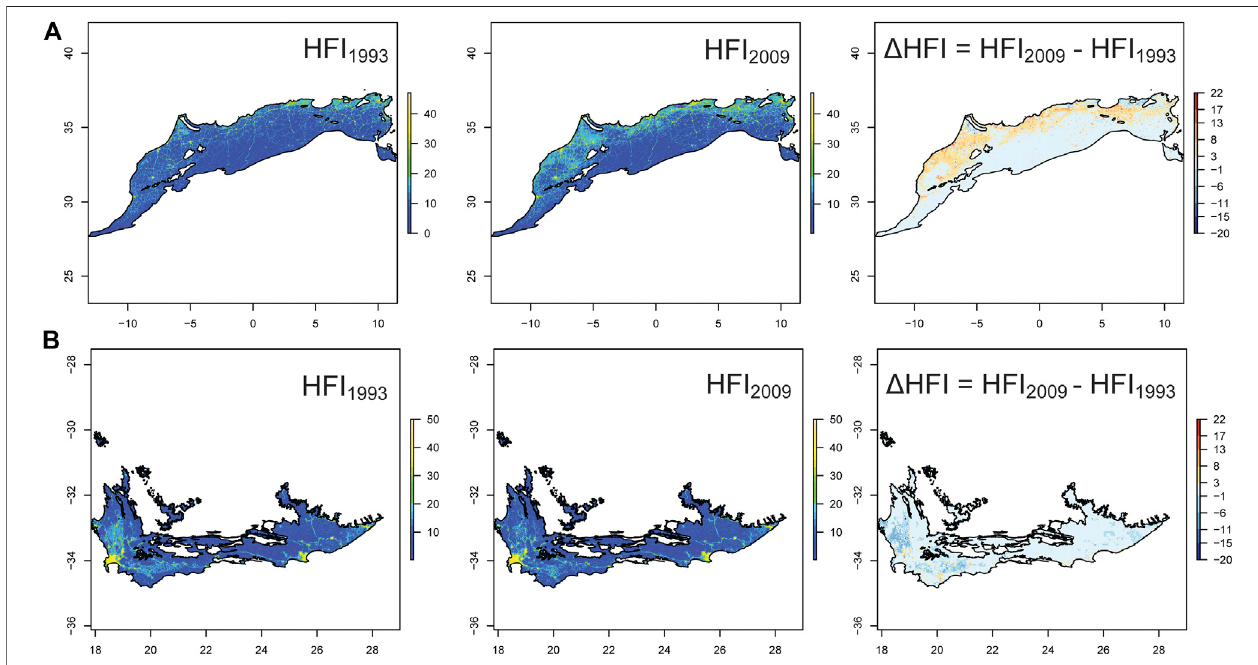
FIGURE 3 | Change in Human Footprint Index (HFI) in the Mediterranean climate of North (NAR) (A) and South (SAR) (B) African regions between 1993 and 2009. The third panel shows the relative change in HFI by subtracting HFI of 2009 from HFI of 1993. HFI ranges from 0 (no human in fl uence) to 50 (very high human in fl uence).